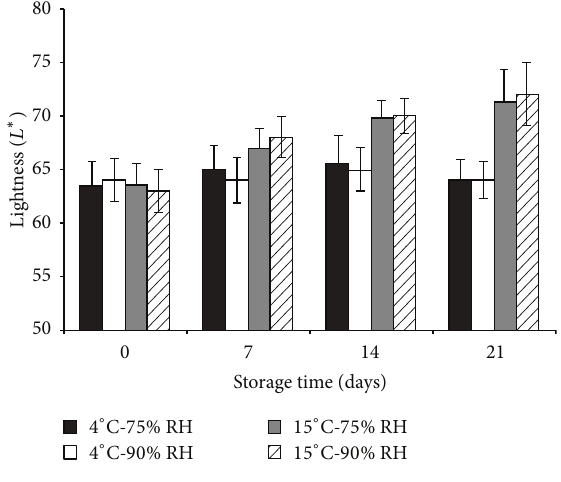
Figure 7: Total lightness ( 𝐿 ∗ ) of “Brigitta” at different temperatures ( ∘ C) and relative humidities (RH) of storage conditions. Similar behavior was observed for other